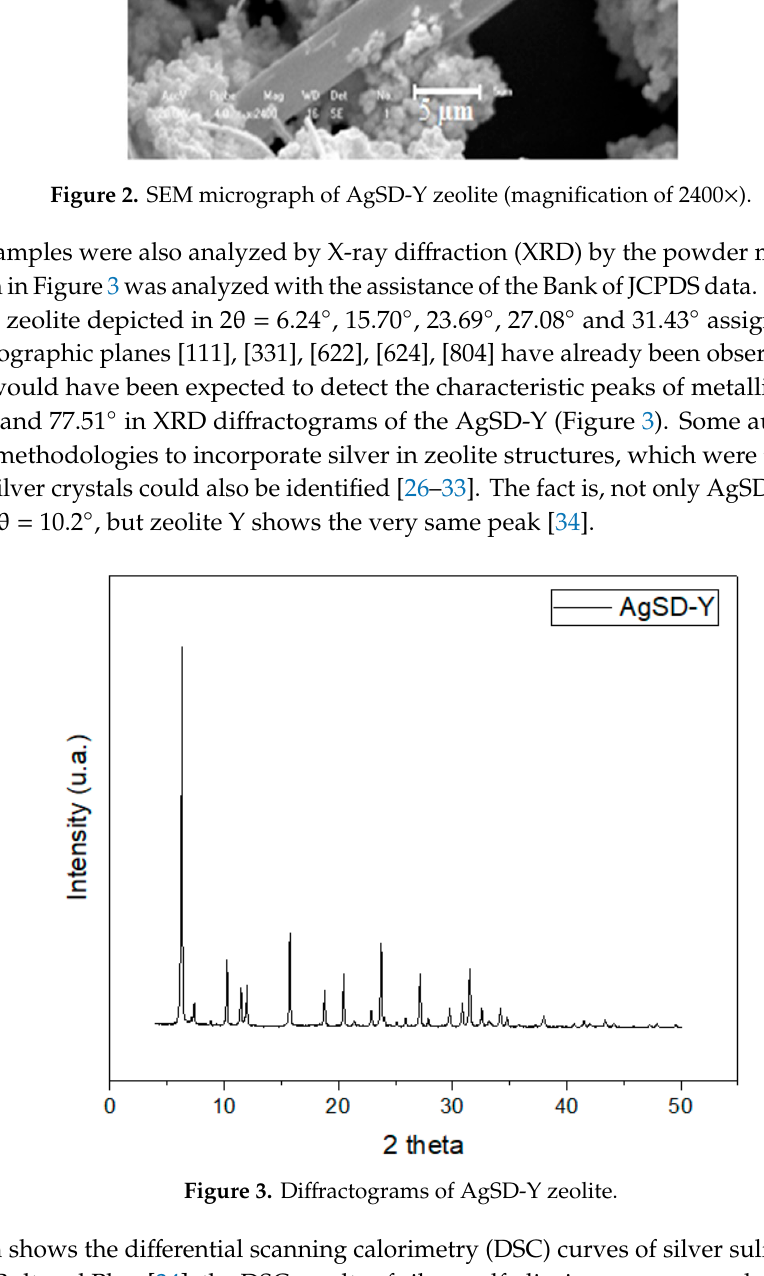
Figure 3. Diffractograms of AgSD-Y zeolite.